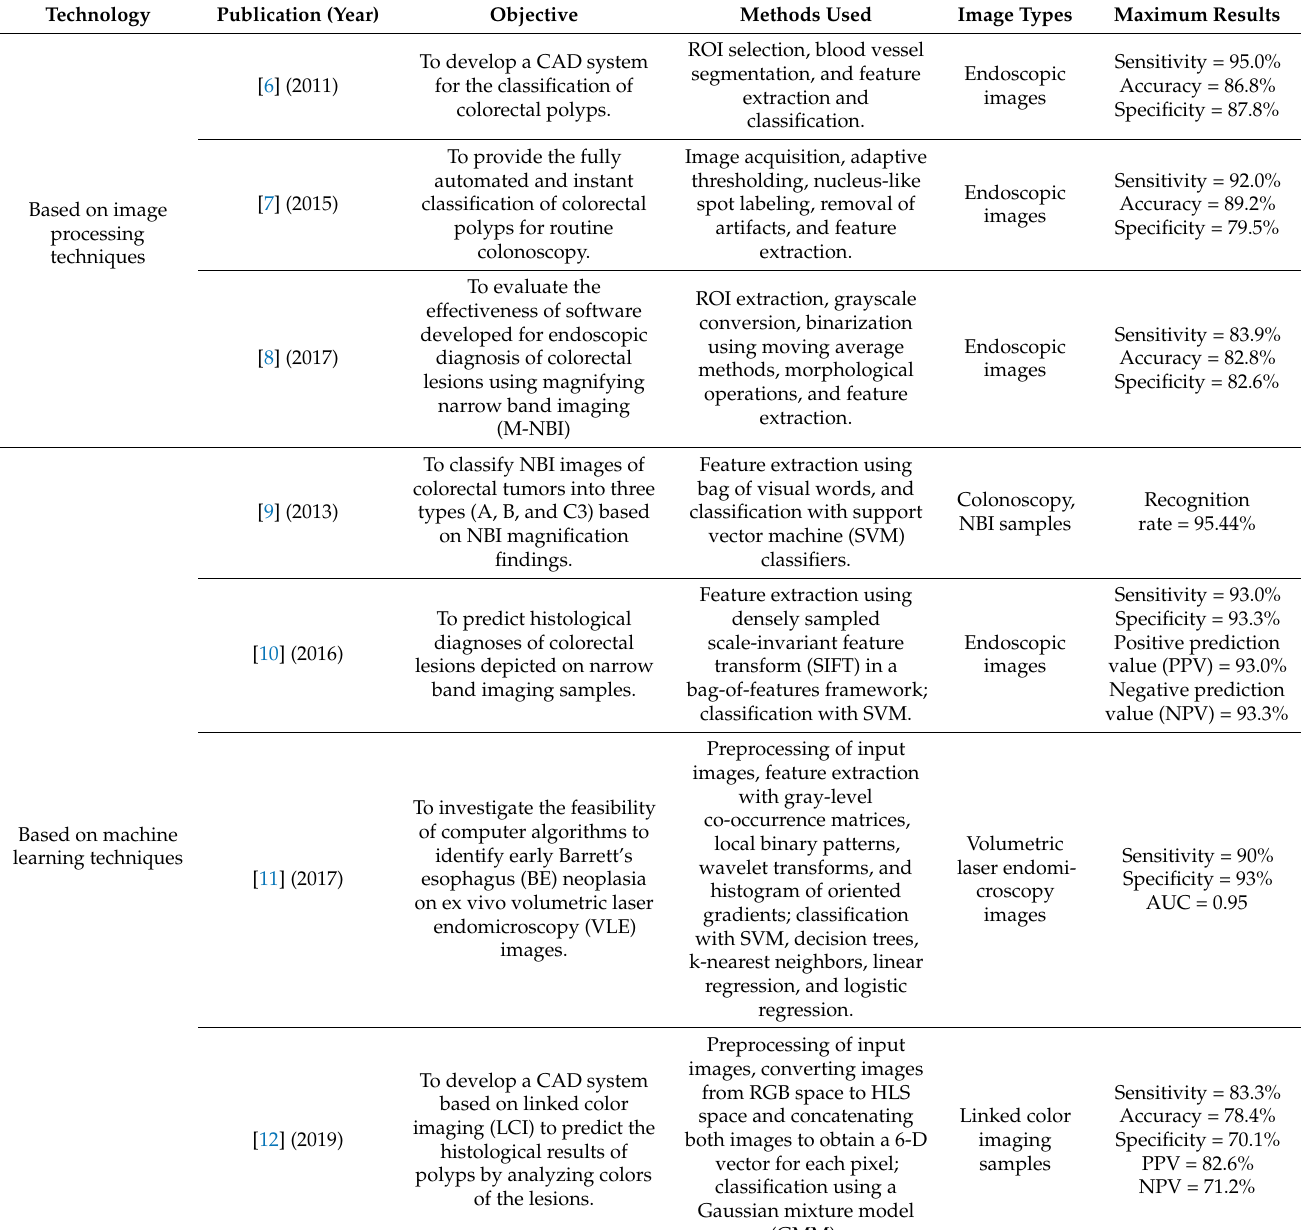
Table 1. Overview of CAD systems based on simple image processing techniques and ML-based techniques.